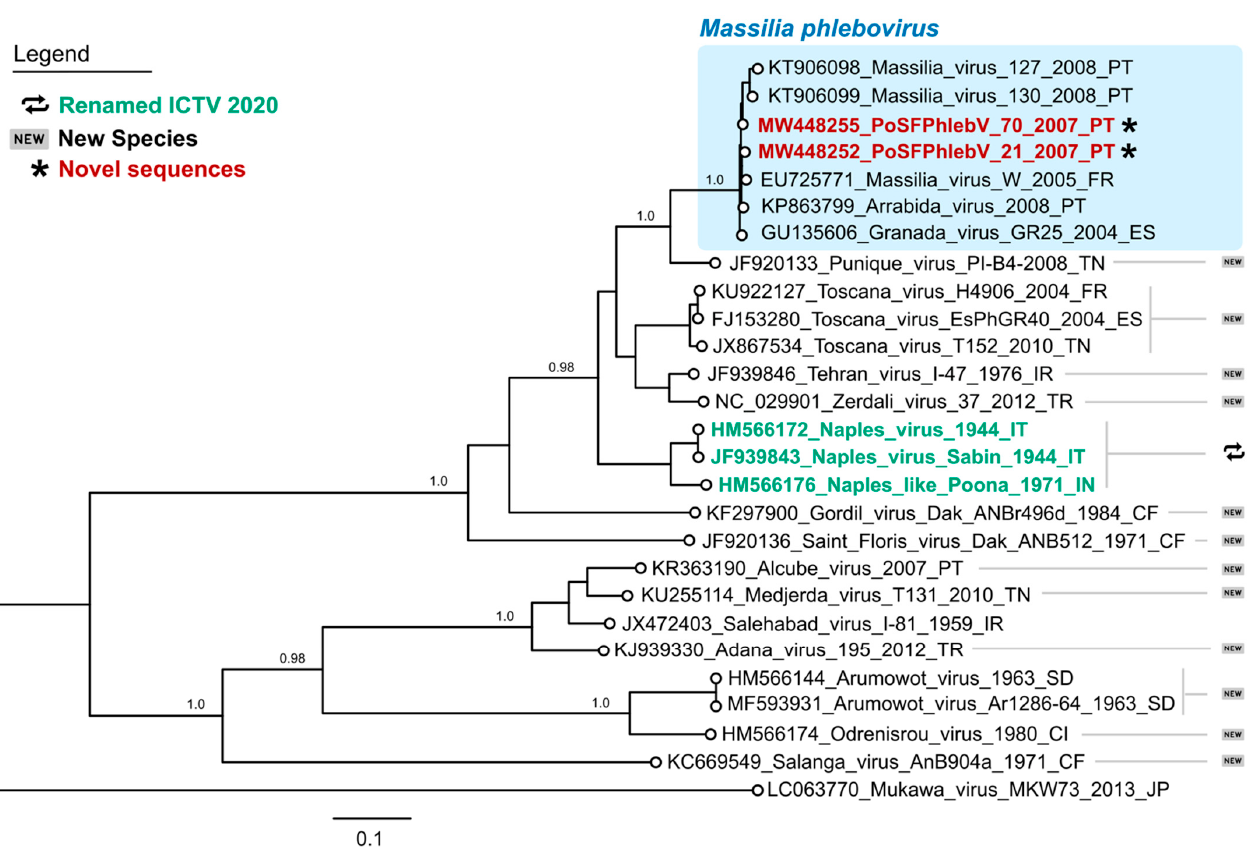
Figure 1. Maximum likelihood phylogenetic tree of phleboviruses entire RNA-dependent RNA polymerase protein sequences. Sequence names in red and marked with an asterisk have been sequenced in this study. According to the International Committee on Taxonomy of Viruses 2020, sequence names in green have recently had their species renamed, while those marked by “new” symbols on the right side of the tree have been assigned as new species. Names of the sequences in the tree match the IDs in the alignment made available as a supplementary file. Numbers on branches are the bootstrap support. The shaded area on the top highlights the Massilia phlebovirus cluster. Used sequence alignment is available in supplementary File S1: Phleboviruses’ amino acid sequence alignment of L segments.